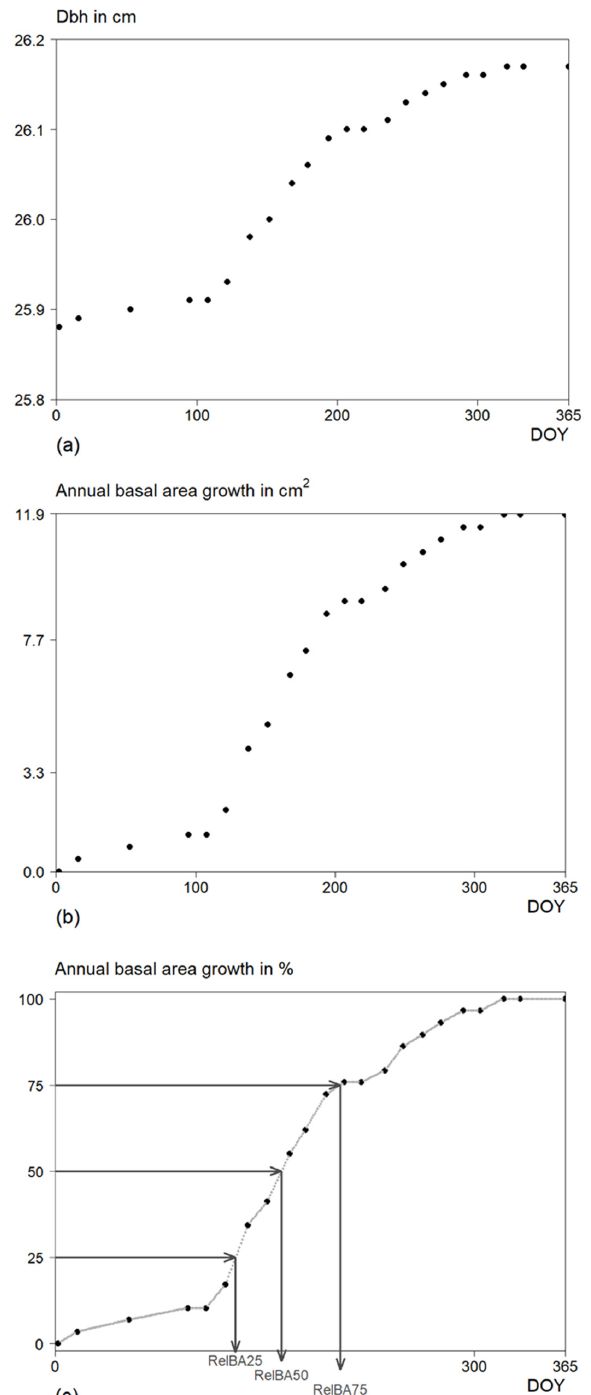
Figure 3. ( a ) The intra-annual course of the diameter (dbh) and ( b ) of the basal area of an example tree. On average, 19.7 diameters per year and tree were recorded. ( c ) Based on an interpolation, the day of the year (DOY) was extracted on which the relative basal area growth achieved 25%, 50% and 75% of the total annual growth.